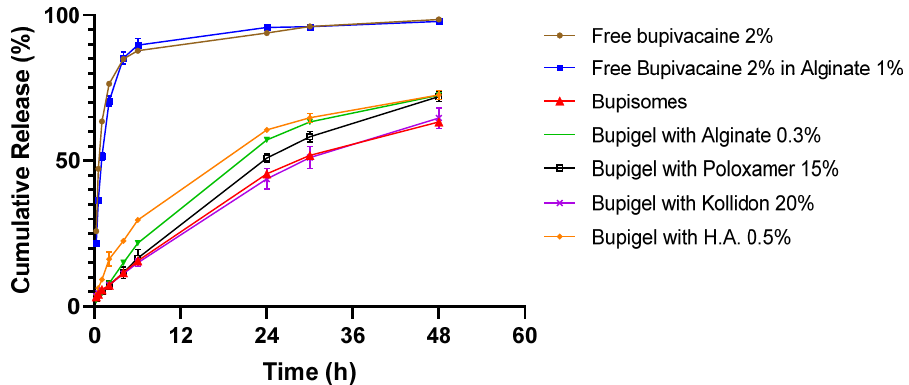
Figure 1. Bupivacaine release profiles from Bupisomes and formulations with different gel-forming agents. The different formulations were incubated at 37 ◦ C under stirring in a standard pharmaceutical dissolution apparatus mimicking subcutaneous depot injection. Bupivacaine was quantified from duplicates of each sample from the upper cell at different time points by HPLC (high-performance liquid chromatography; mean ± SD). H.A., hyaluronic acid.